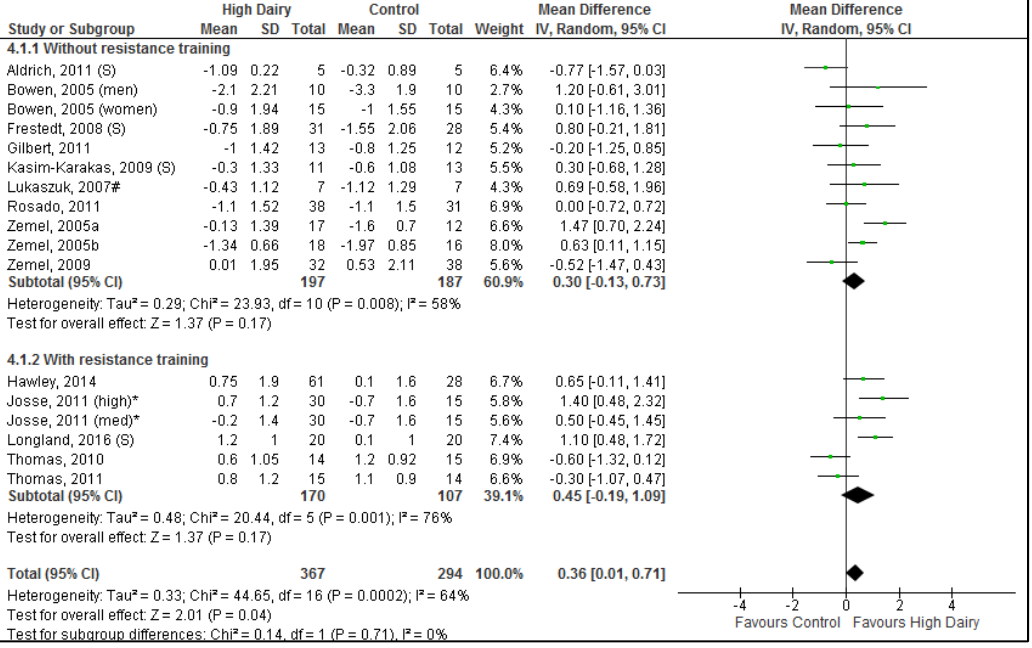
Figure 4. Forrest plot of mean (95% CI) weighted differences in body lean mass (kg) between high dairy and control groups stratified for sub-groups with resistance training vs. without resistance training. (S) The intervention was dairy supplements; # The comparison group was soy protein; * Sample size adapted for multiple comparisons to avoid data duplication; med, medium dairy group; high, high dairy group.